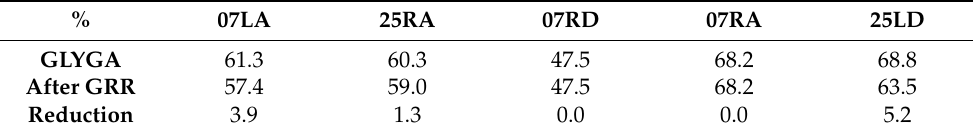
Table 2. Comparison of Hit Rate before and after application of